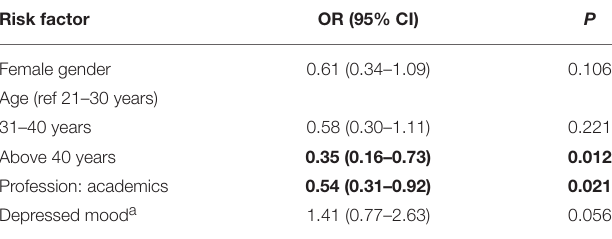
TABLE 5 | Association between sitting too much and depressed mood after adjusting for age and gender. Risk